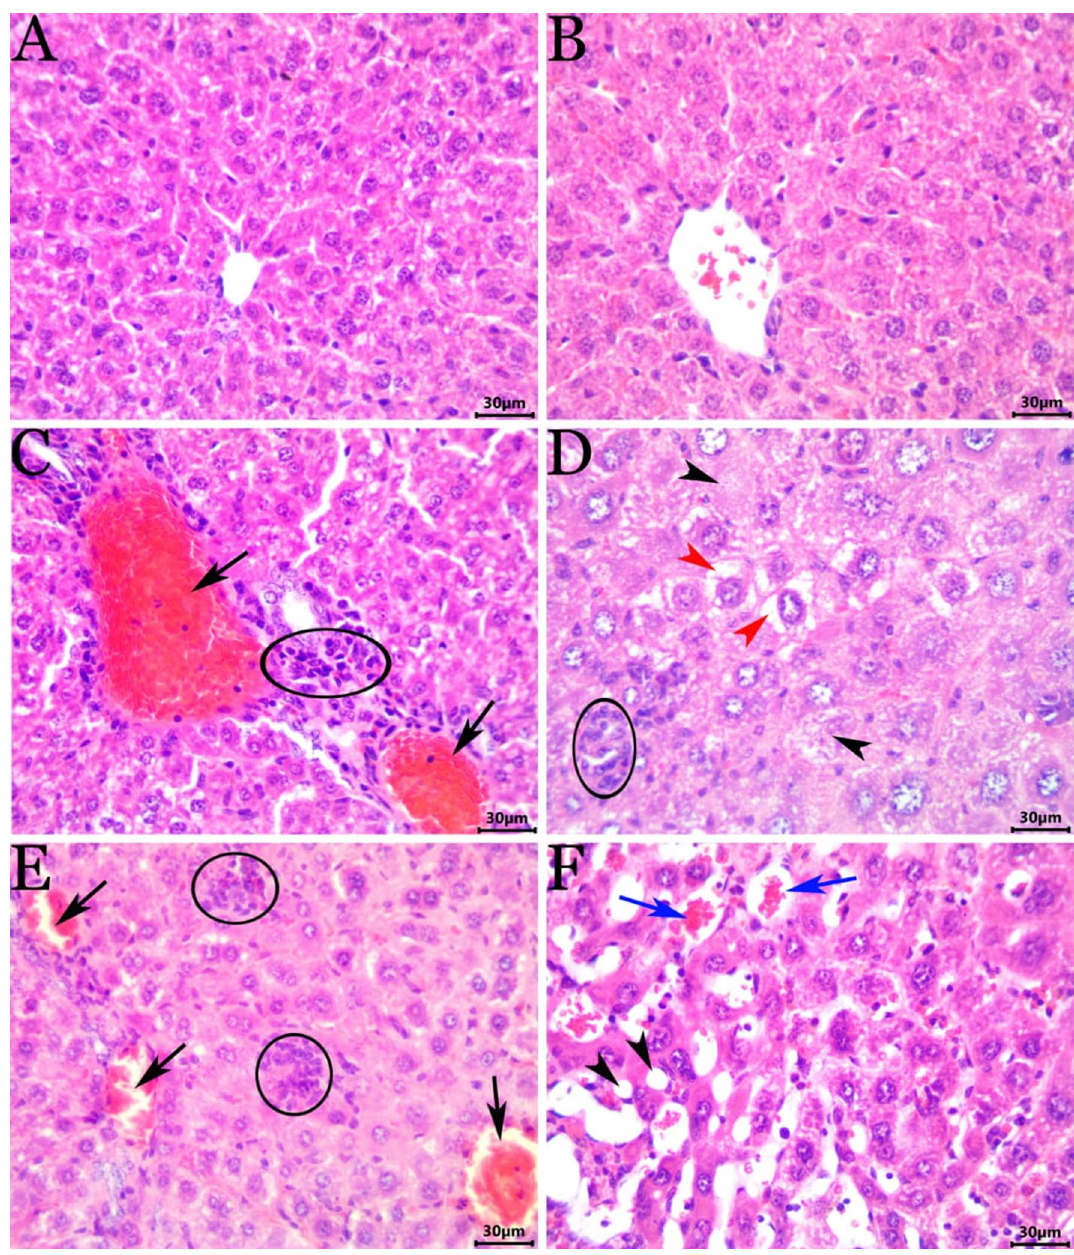
Figure 4. Representative photomicrograph of hematoxylin and eosin stained hepatic tissue sections showing the effects on the hepatic histology of exposure to NaNO 2 and/or T. vulgaris . ( A ) and ( B ), normal histological photomicrographs in the control and T. vulgaris -treated mice, respectively. ( C ) and ( D ), livers of the NaNO 2 - treated mice showing portal congestion (arrows), inflammatory cell infiltrate (ellipses), cellular swelling associated with hydropic degeneration (red arrowheads), and single-cell necrosis (black arrowheads). ( E ) and ( F ), livers of NaNO 2 + T. vulgaris -treated mice showing focal mononuclear cell aggregates (ellipses), fatty change (black arrowheads), congested blood vessels (black arrows), and sinusoids (blue